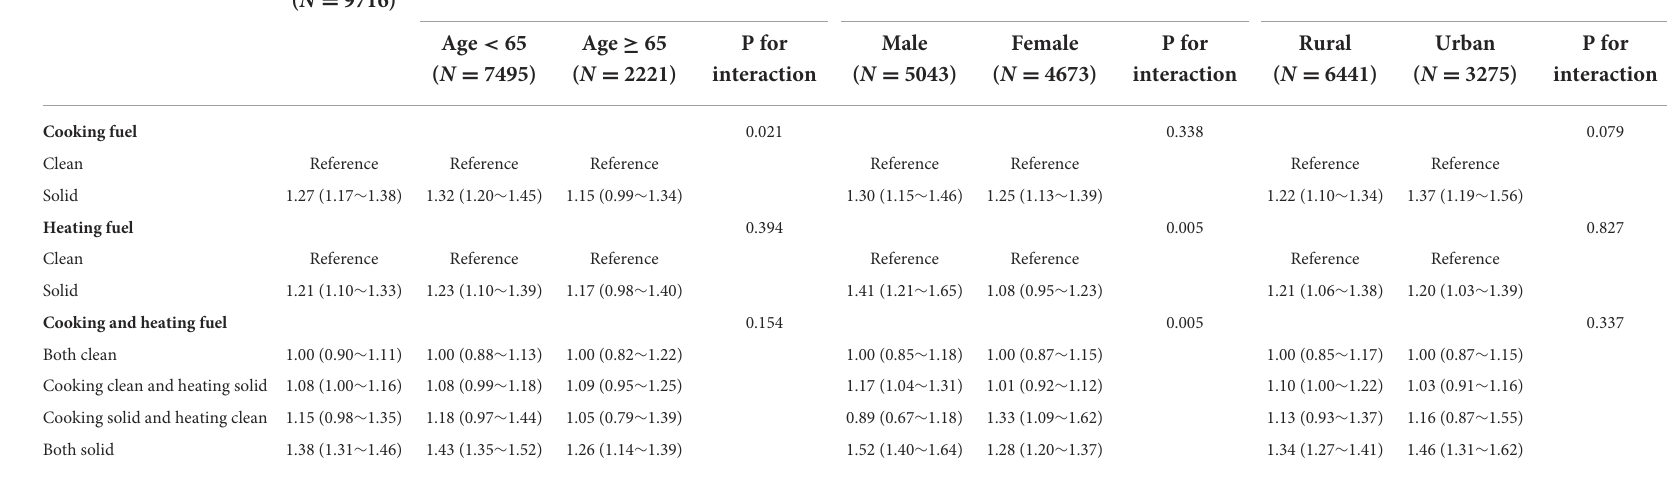
TABLE 2 HR (95% CI) of fuel usage with new-onset IADL disability: Cox proportional-hazards